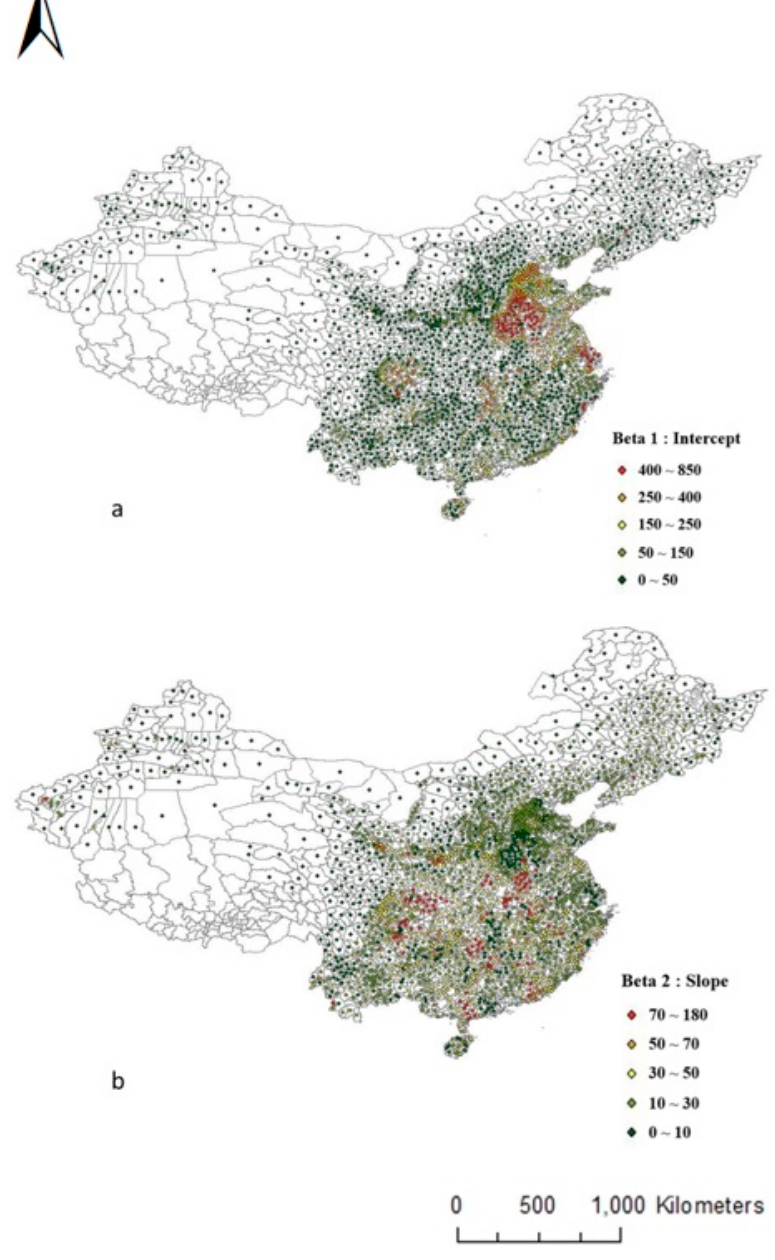
Figure 7. Spatial maps of ( a ) intercept and ( b ) slope coefficients in ANNGWR in 2007.